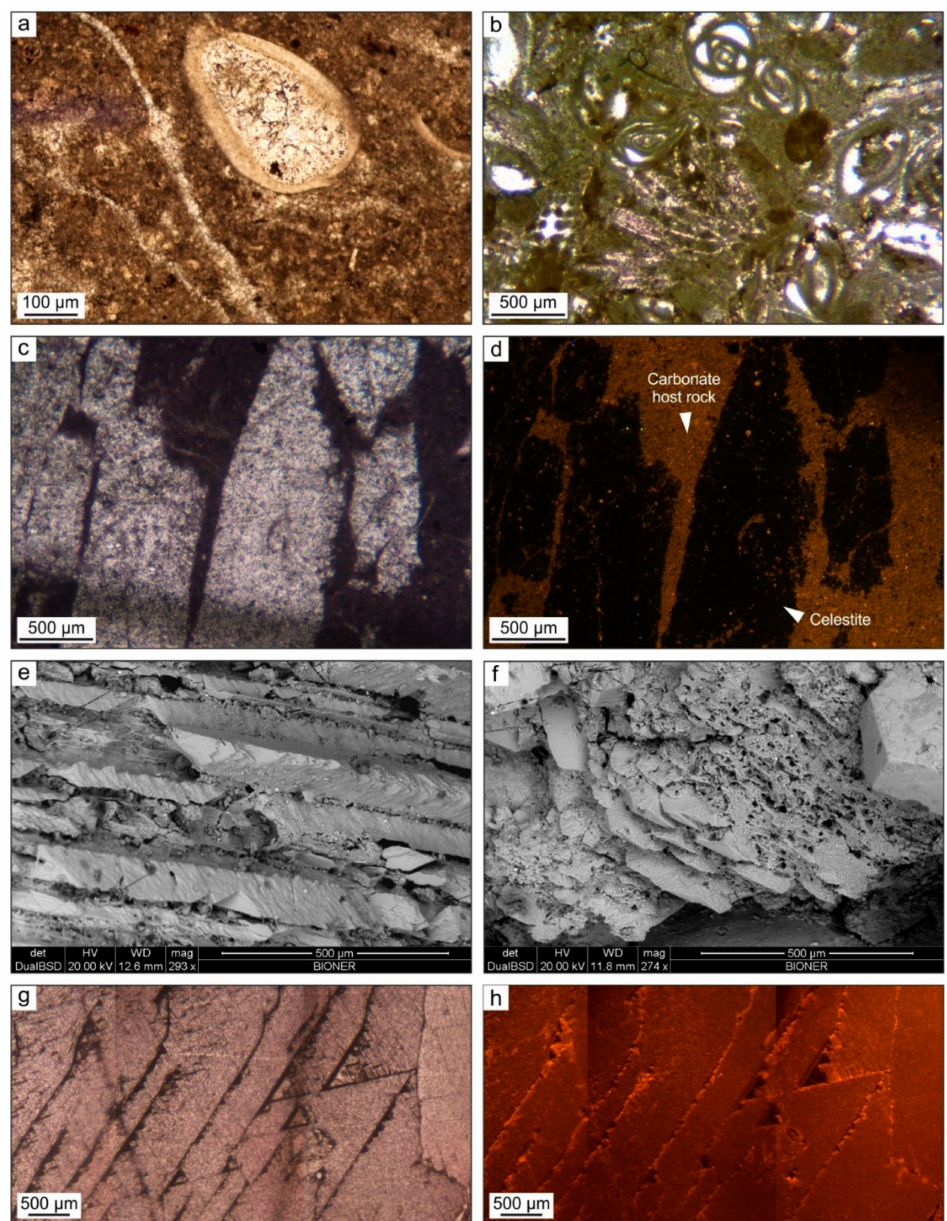
Figure 4. Images from polarizing optical, electron (SEM), and cathodoluminescence (CL) microscopes of the main features of the upper carbonate unit of the Corones Formation and studied bladed calcites. ( a ) Optical microscope image (PPL, plane polarized light) of an ostracod cemented by blocky calcite crystals. ( b ) Optical microscope image (PPL) of a packstone of miliolids and other unknown components. ( c , d ) Optical (PPL) and CL images of celestite crystals growing within the carbonates of the Corones Formation. ( e ) SEM image of rhombic calcite subcrystals forming the bladed crystals. ( f ) SEM image of µ m-scale bladed calcite subcrystals. ( g , h ) Optical (PPL) and CL images of bladed